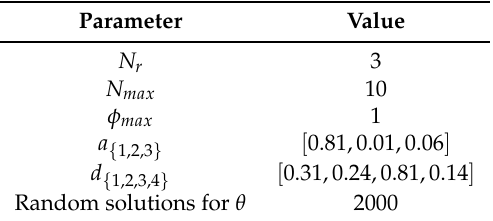
Table 3. Simulation parameters for the one-shot game when equilibrium does not exist.